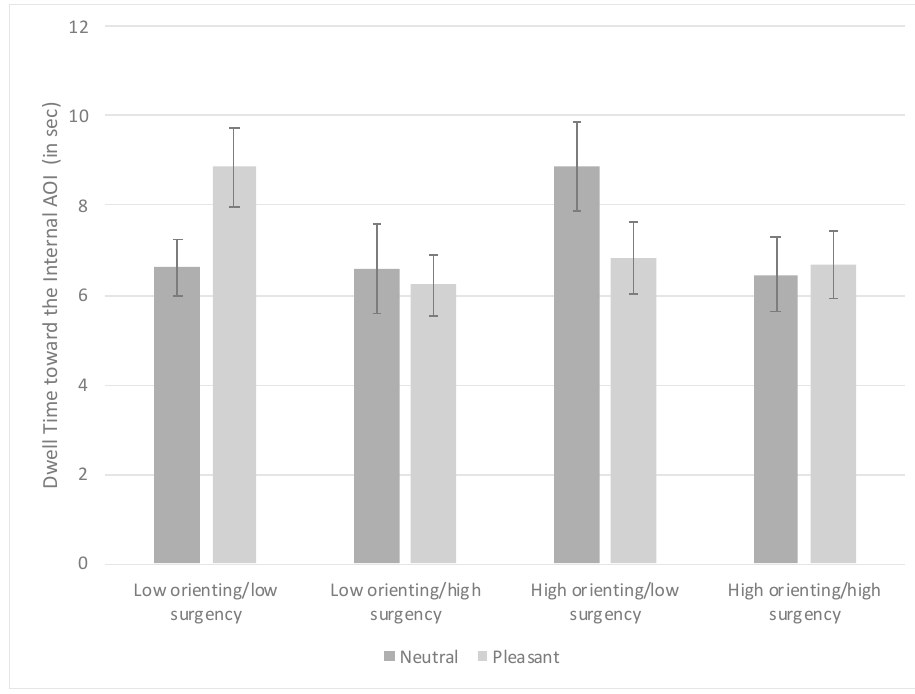
Figure 4. Dwell time toward the internal features of the familiarized face based on facial expression and infants’ orienting and surgency. Bars represent standard error .